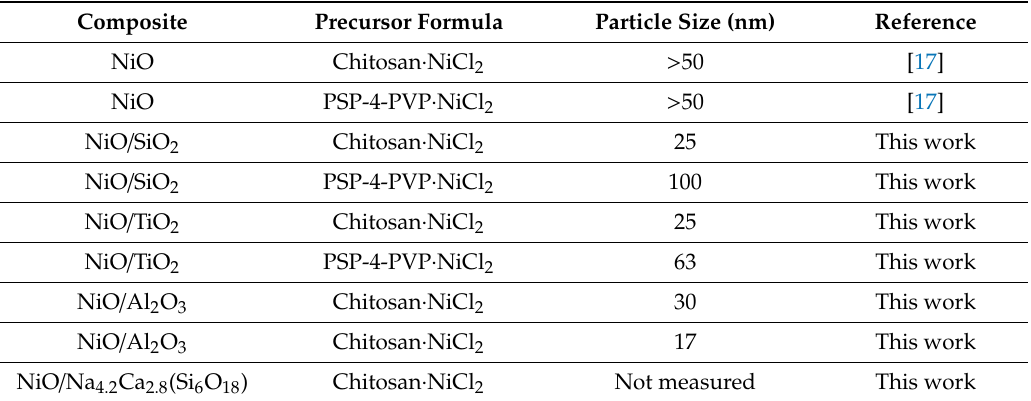
Table 2. Nanoparticle size for the